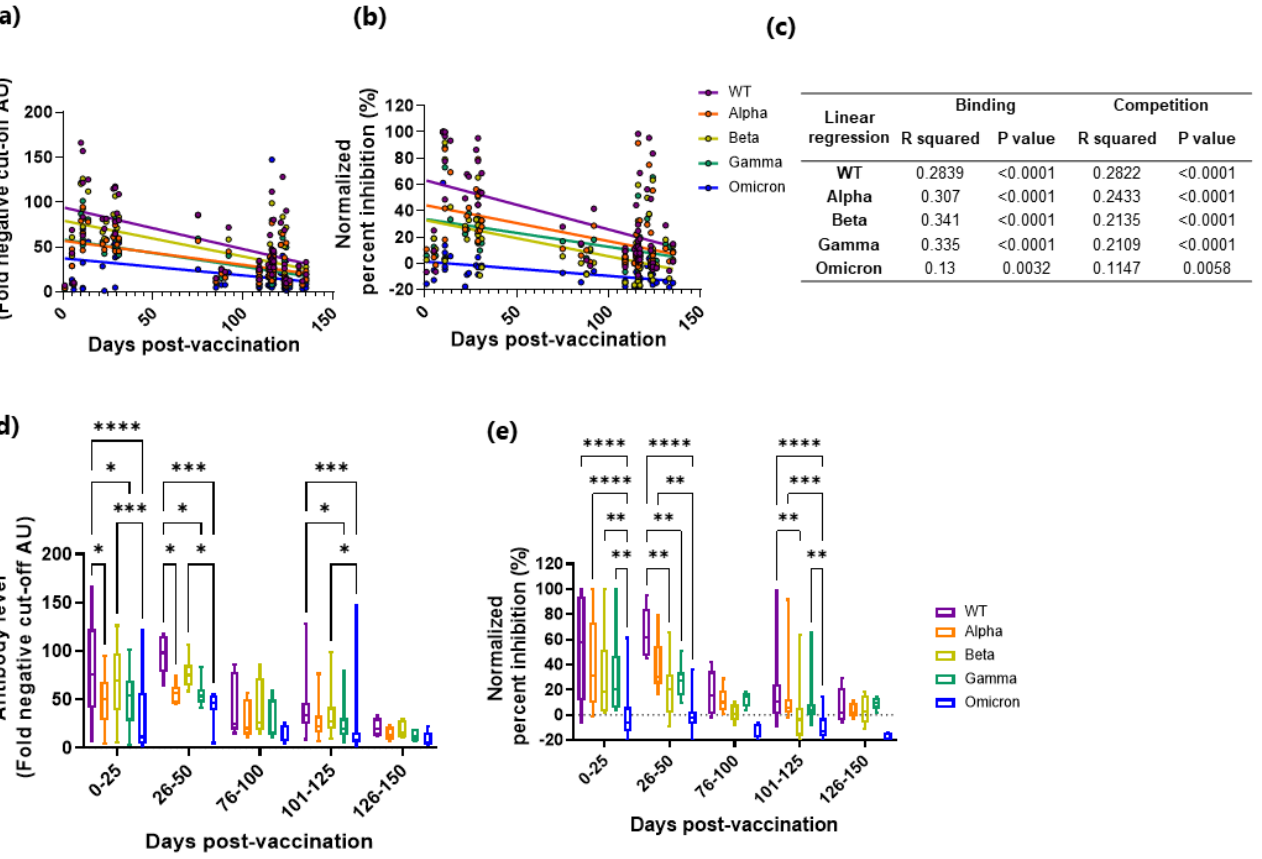
Figure 4. IgG binding and ACE2 competition measured against SARS-CoV-2 WT and the VoCs in vaccinated subjects stratified as days post-vaccination. Levels (fold negative cut-off) of IgG ( a , d ), and ACE2 competition (normalized percent inhibition, ( b , e )) were measured in vaccinated subjects as days post-vaccination against the WT and the VoC (WT, purple; Alpha, orange; Beta, yellow; Gamma, green; Omicron, blue). Linear regression ( a ). IgG levels and b. ACE2 competition) was fitted and linear regression analysis performed ( c ). The data was also stratified into time windows of 25 days and responses measured between the WT and the VoC by two-way ANOVA (( d ). IgG levels and ( e ). ACE2 competition, * p = 0.05, ** p = 0.01, *** p = 0.001, ****, and p = 0.0001).